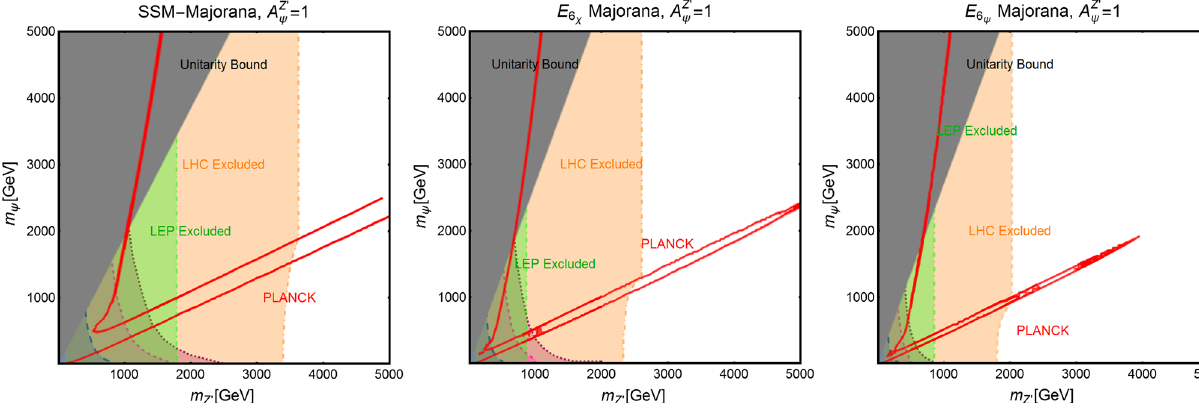
Fig. 14 The same as Fig. 13 but for a Majorana fermion DM where V Z (cid:15) ψ =